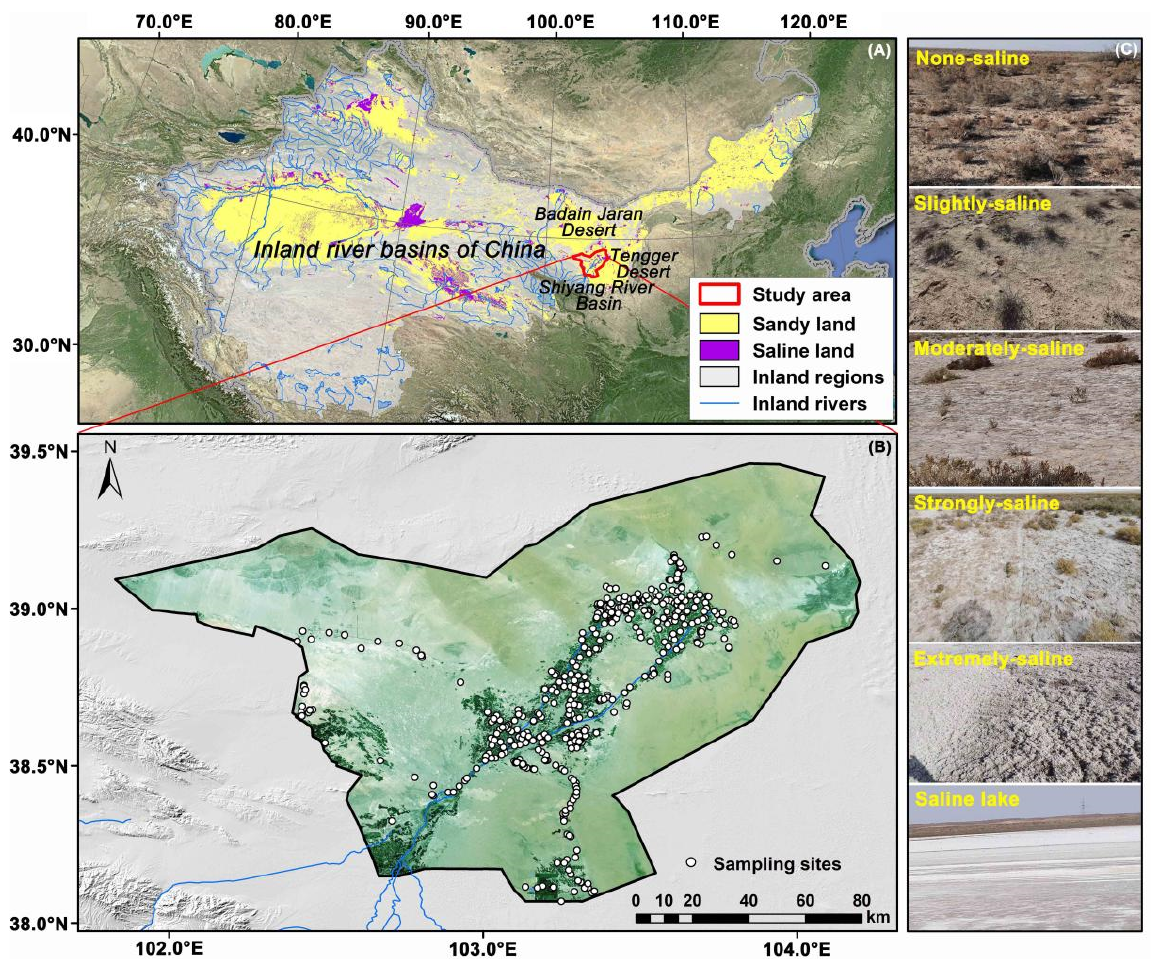
Figure 1. Locations of the study area ( A ), distribution of soil sampling sites ( B ), and photographs of salinity-affected soils in the study area ( C ).